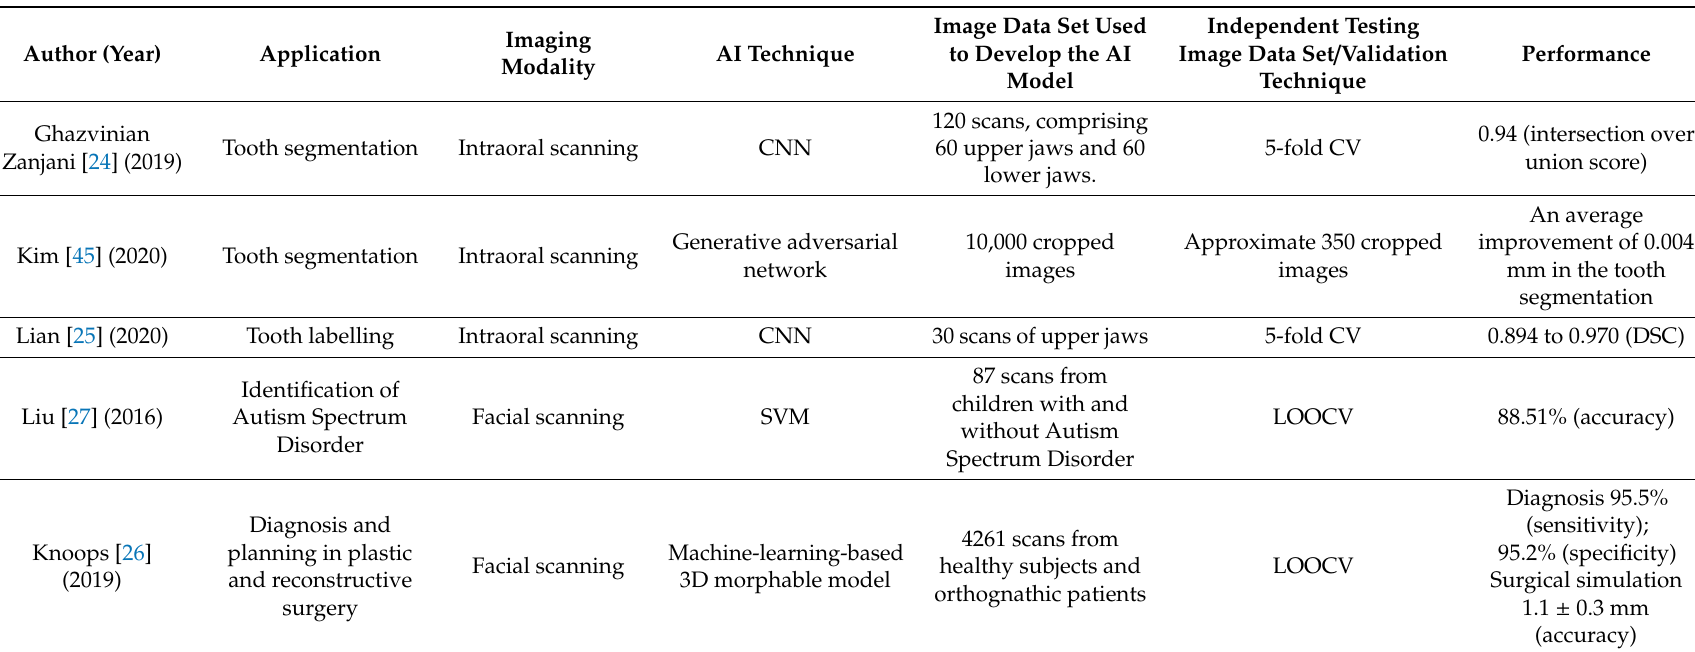
Table 2. Characteristics of the machine learning-based AI models based on intraoral and facial